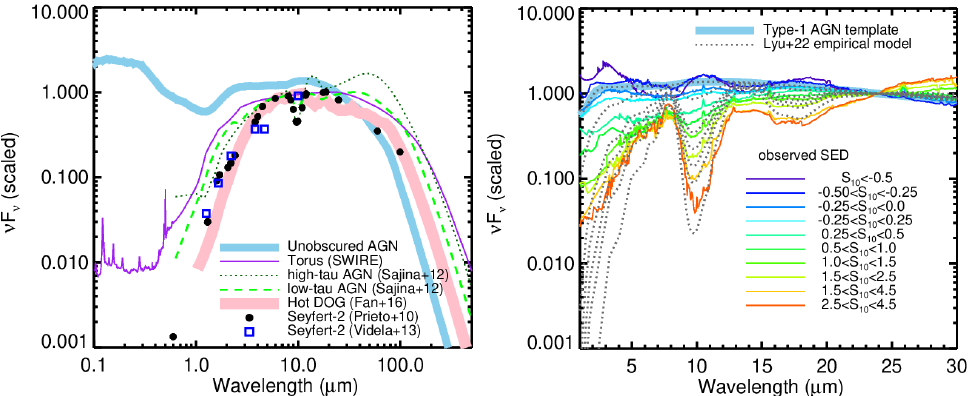
Figure 5. ( Left ): Type 2 AGN SEDs derived in the literature, including the average SEDs of Seyfert-2 nuclei derived by Prieto et al. [45] and Videla et al. [47], the torus template in the SWIRE library [49], the IR SED templates for high- τ 9.7 and low- τ 9.7 ( τ 9.7 , respectively, > and < 1) IR bright quasars from Sajina et al. [50], and the average SED of hot-dust-obscured galaxies from Fan et al. [51]. The SED template of unobscured AGNs from Elvis et al. [32], Xu et al. [52] is also presented as a comparison. ( Right ): The IR SEDs of obscured AGNs at 2–30 µ m. We have computed the average SEDs of AGNs with different 10 µ m silicate feature strength ( S 10 = log ( F obs. / F cont. ) = − 0.5–4.5) with Spitzer /IRS spectra and 2MASS photometry (colorful solid lines). The grey dashed lines represent the SED model after applying the Lyu & Rieke [53] AGN attenuation curve to the normal AGN template (as defined in Figures 3 and